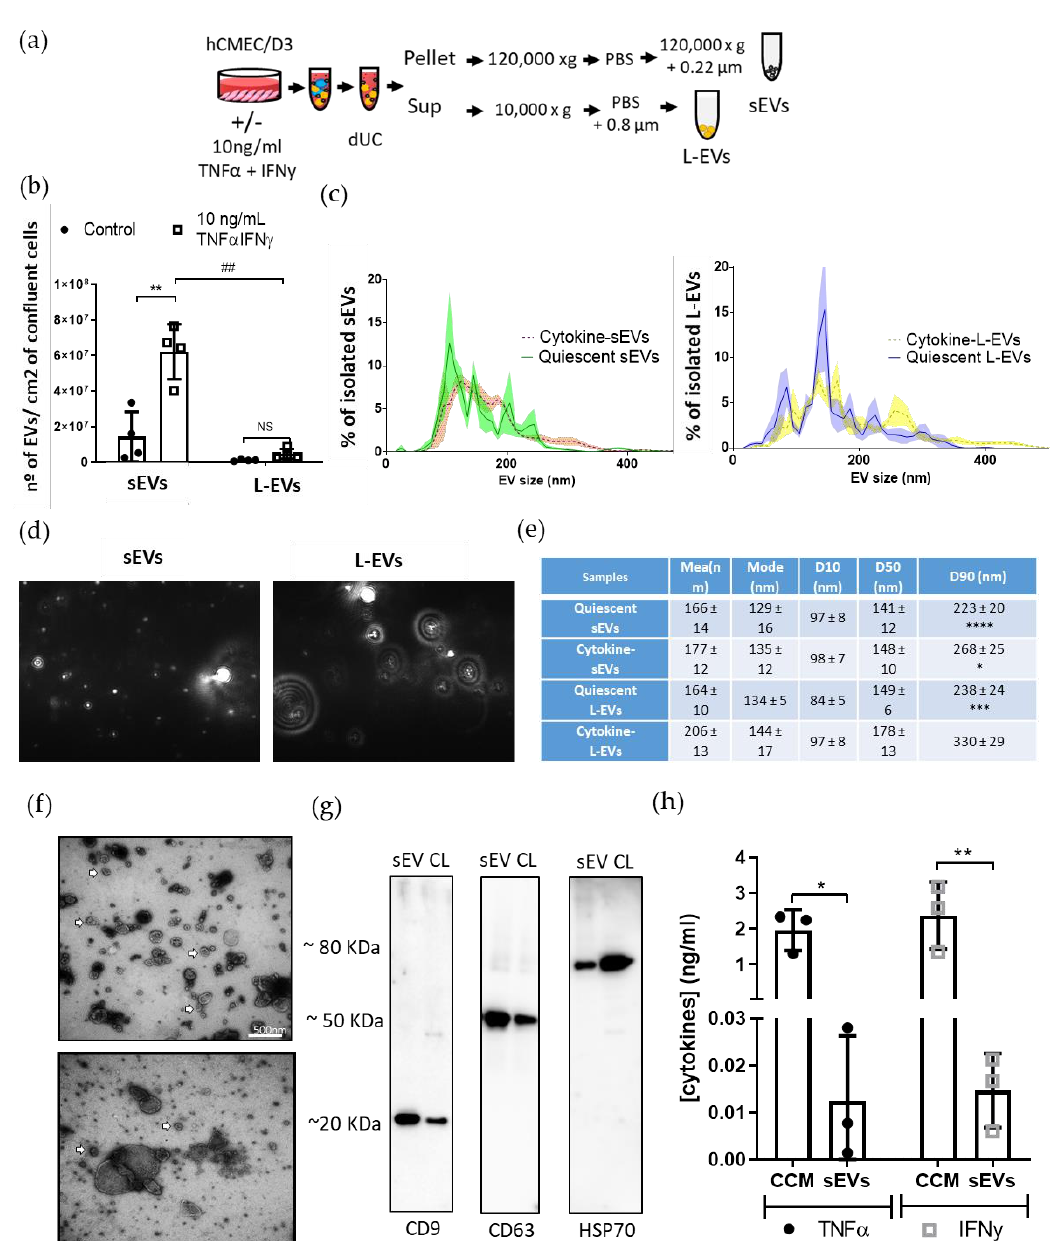
Figure 1. Characterisation of extracellular vesicles in inflammation. ( a ) Graphic diagram of the isolation of extracellular vesicles (EVs) both small (sEVs) and large (L-EVs) from untreated hCMEC/D3 cells (quiescent sEVs or L-EVs) and those incubated with 10-ng/mL TNF α and IFNy (cytokine-sEVs or -L-EVs) for 24 h using a combination of ultracentrifugation (dUC) and filtration steps. ( b ) Nanoparticle tracking analysis (NTA) measurements of isolated EVs revealed significantly increased numbers of cytokine-sEVs after the cytokine treatment compared to the controls. ( c ) Size distribution measured by NTA showed that most isolated EVs were smaller than 200 nm in all EV subsets (left image shows sEVs, whereas the right image shows L-EVs). ( d ) Representative images of cytokine-sEVs and L-EVs from the Nanoparticle Tracking Analysis ( e ) The table summarises the mean; mode and D10, D50 and D90 diameter sizes of sEVs and L-EVS. ( f ). Transmission electron microscopy (TEM) images of cytokine-sEVs and cytokine-L-EVs. Arrows point to sEVs in both images. ( g ) Immunoblots for CD9, CD63 and HSP70 in cytokine-sEVs (sEV) and cell lysate (CL) controls. ( h ) Concentrations of TNF α and IFNy in the cytokine-sEV fractions and cell-conditioned medium (CCM). Data are shown as the mean ± SEM, n = 2 ( d ), n = 3 ( f ) and n = 4 ( b , c ). The means were compared with one-way ANOVA, followed by Tukey’s post-hoc test. * p < 0.05, ## or ** p < 0.01, *** p < 0.001 and **** p <